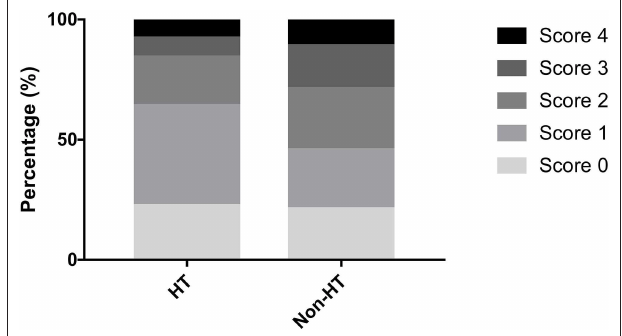
FIGURE 3 | Percentages of different cerebral SVD scores in patients with or without HT.